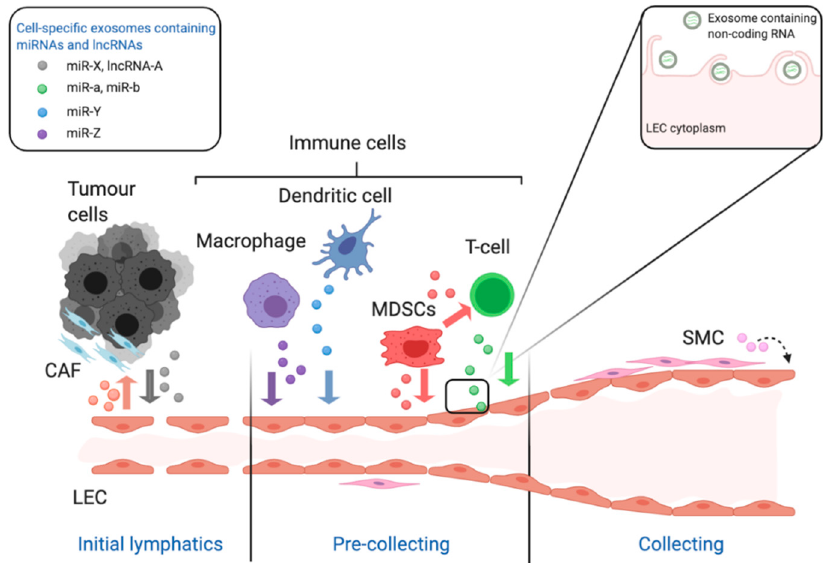
Figure 2. The schematic diagram illustrates the role of non-coding RNA in the growth and re- modelling of lymphatic vessels in the context of cancer. The lymphatic system is composed of a hierarchy of vessels starting with blind-ended initial lymphatics which allow the entry of cells and fluid via their incomplete junctions. Lymph fluid then flows through more structured pre-collecting vessels to collecting vessels which acquire a complete lining of smooth muscle cells. All of these lymphatic vessels are lined with specialised lymphatic endothelial cells (LEC). In the context of cancer miRNA and long non-coding RNA are released from tumour cells and cells of the tumour microenvironment via exosomes. This includes but is not limited to tumour cells, macrophages, dendritic cells, T-lymphocytes and smooth muscle cells. These cells release exosomes containing specific miRNAs and lncRNAs, which is indicated in the legend and by the coloured coded exosomes in the figure. The insert shows the interaction of the exosomes with the membrane of LEC which then internalise the exosomes containing ncRNA for interaction with cellular proteins and RNA/DNA. These abbreviations used are: LEC stands for lymphatic endothelial cell, CAF for cancer-associated fibroblast, MDSC for myeloid-derived suppressor cells and SMC for smooth muscle cell. This figure was created with